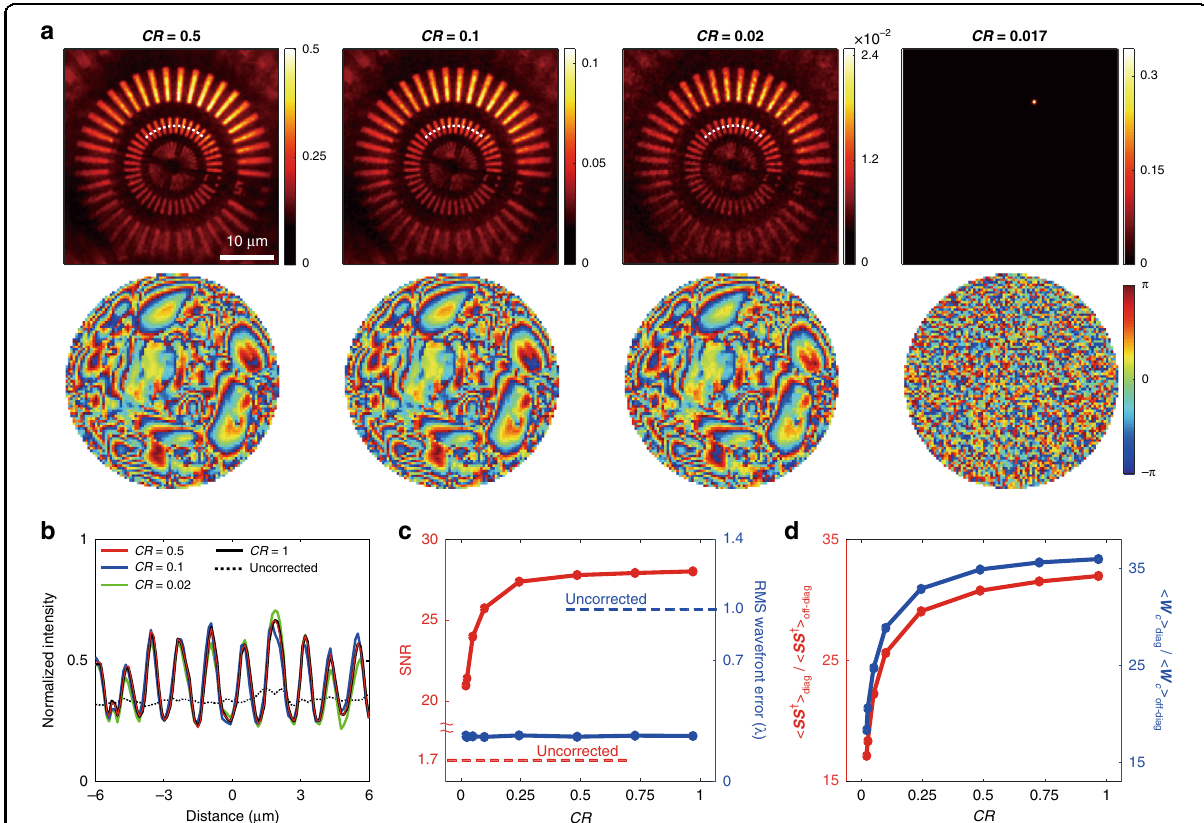
Fig. 4 Image reconstruction fi delity depending on the compression ratio ( CR ). a Aberration-corrected images (upper row) and corresponding aberration maps (lower rows) for various CR values. b Line pro fi les along the white dashed lines in ( a ). c SNR (red dots) and residual RMS wavefront error (blue dots) depending on CR . d Ratio between the averaged diagonal elements and off-diagonal elements of SS † (red dots) and W c (blue dots) depending on CR . The solid curves in ( c , d ) are linear interpolations of the